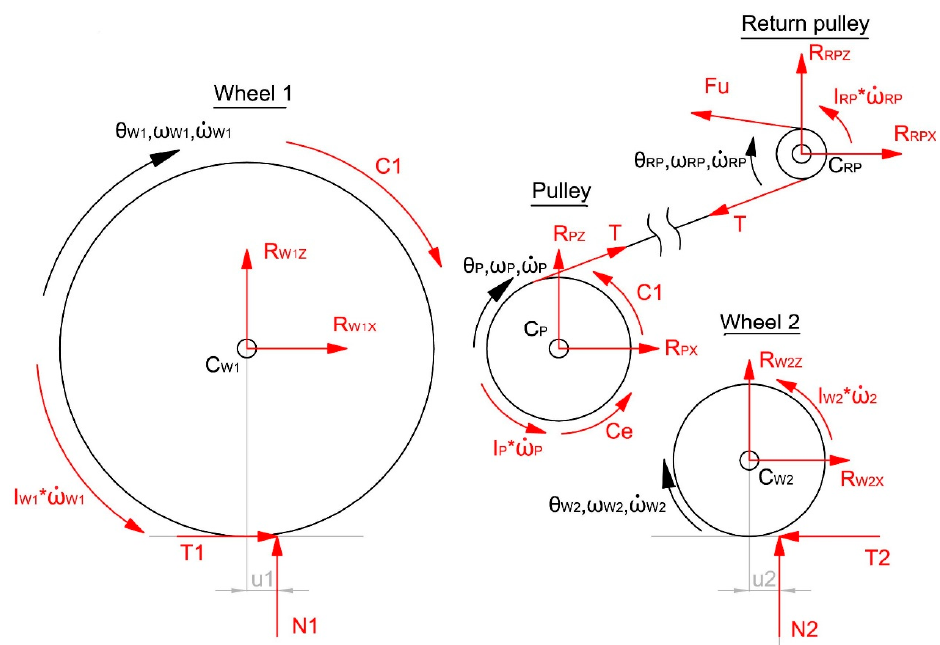
Figure 12. Free-body diagram of wheel 1, wheel 2, the pulley and the return pulley.